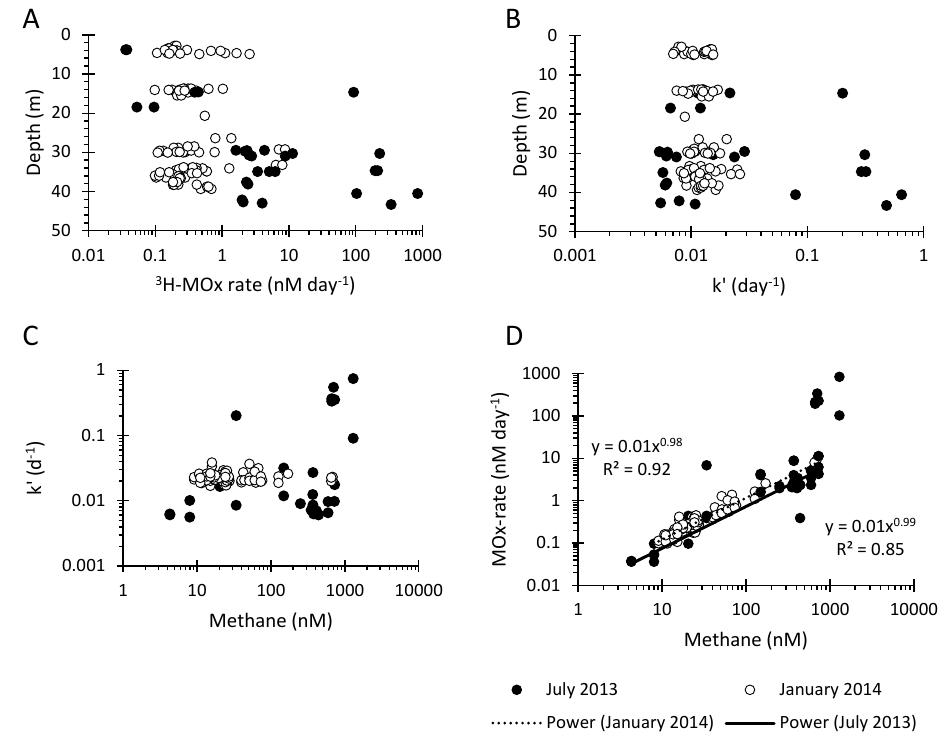
Figure 6. Methane oxidation rates versus water depth measured with 3 H-methane in July 2013 and in January 2014 (a) . (b) The first-order rate constant k (cid:48) of summer and winter samples indicating the relative activity of the water. (c) k (cid:48) versus methane concentration illustrate similar k (cid:48) values over a wide range of methane concentration. (d) Methane oxidation rates versus methane concentrations shows for most of the data a first-order function: MOx = 0.01[CH 4 ] 1 (function with R 2 of 0.92 derived from winter data and with R 2 of 0.85 from summer data).